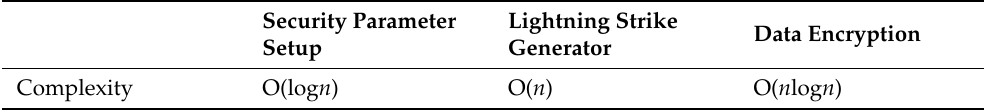
Table 6. Complexity Analysis.